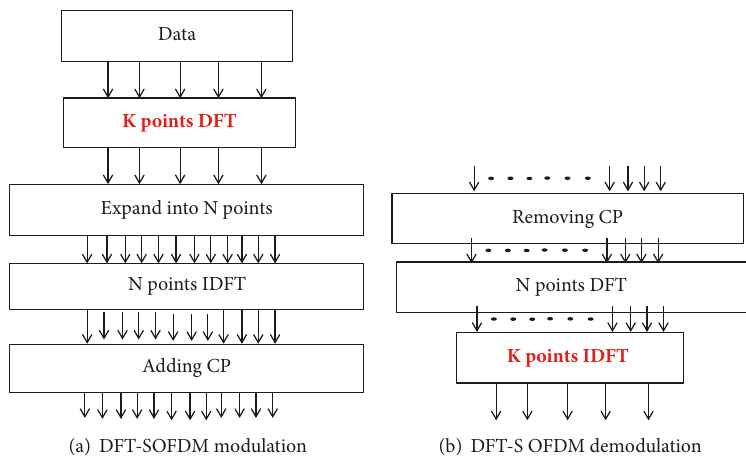
Figure 2: Principle of the DFT-Spread OFDM signal generation and